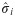
(a) A plot of the standard deviation σ^i
vs. the log of the mean y^i, extracted from abundance data (blue dots). For comparison, clonal tags distributed within the peripheral blood cells were randomly sampled (with the same sampling fraction ε(tj) at times tj as in the experiment). The analogous quantity σi shown by the green triangles indicates a much lower standard deviation for a given value of ln yi. This simple test implies that the clonal variability across time cannot be explained by random sampling. (b) The same test is performed after applying our model with the LSE parameter Le = 23.4 (and the average of parameters listed in Table 1).